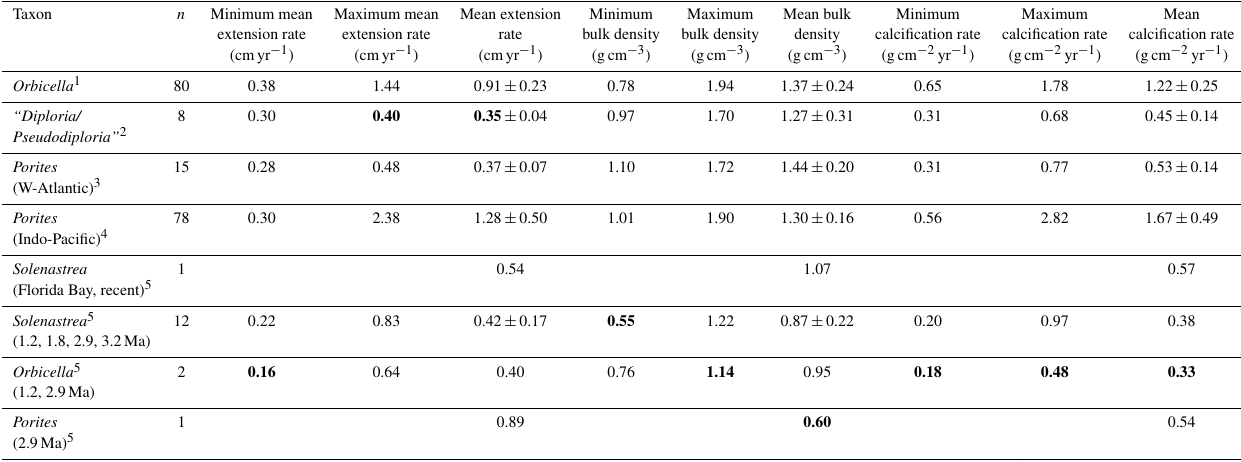
Table 2. Extension rate, bulk density and calcification rate in recent and fossil reef corals. Bold: minimum values. Data sets listing only extension rates not included in this